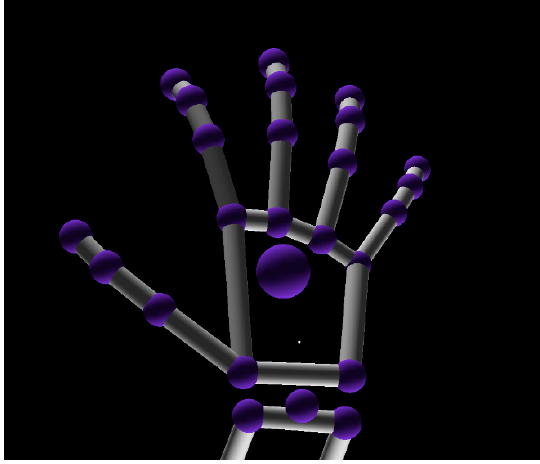
Figure 5. Hand model in Leap Motion.